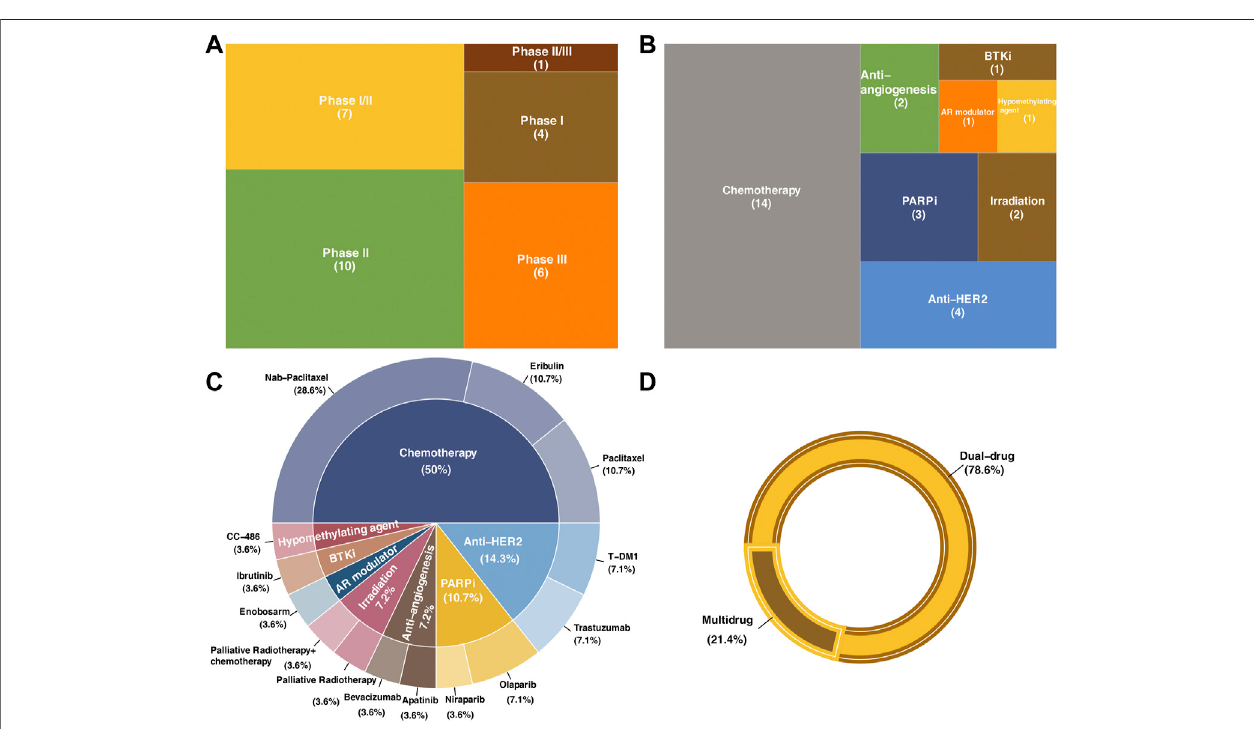
FIGURE3| Statisticsofclinicaltrialsincluded inthepresentreview. (A) Distributionoftheresearchphaseofclinicaltrialsinthisreview. (B) Therapeuticstrategiesin combination with immune check point blockades. (C) Drugs used in each clinical trial and the correspond proportion. (D) Proportions of dual-drug strategies and multidrug